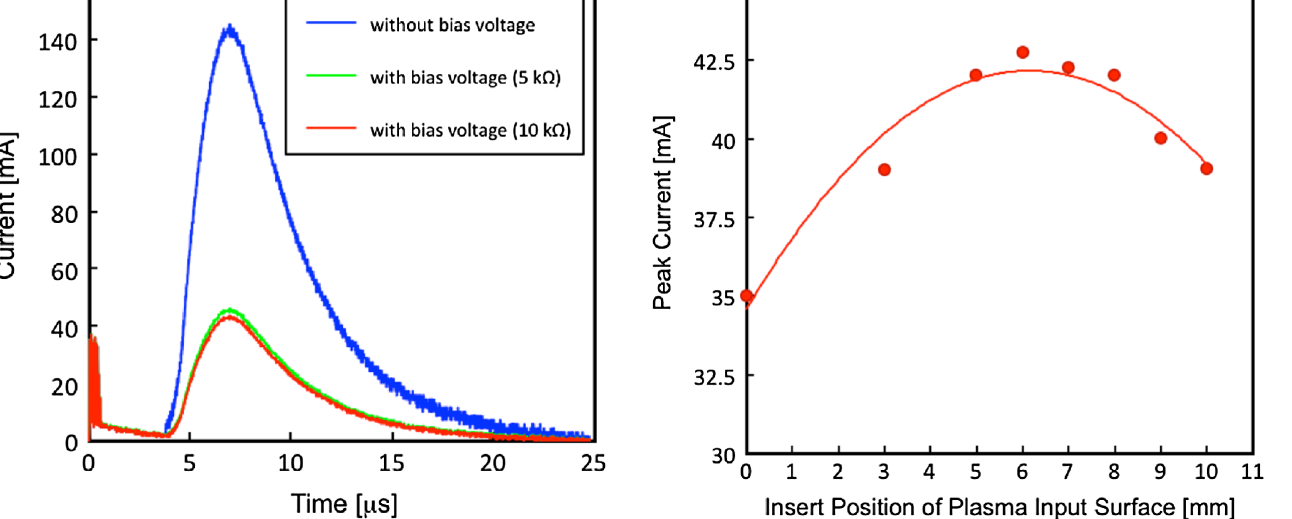
FIG. 31. Peak output current from beam channel 1 as a func- tion of the plasma input position (pickup voltage: 5.2 V; extrac- tion voltage: 30 kV).